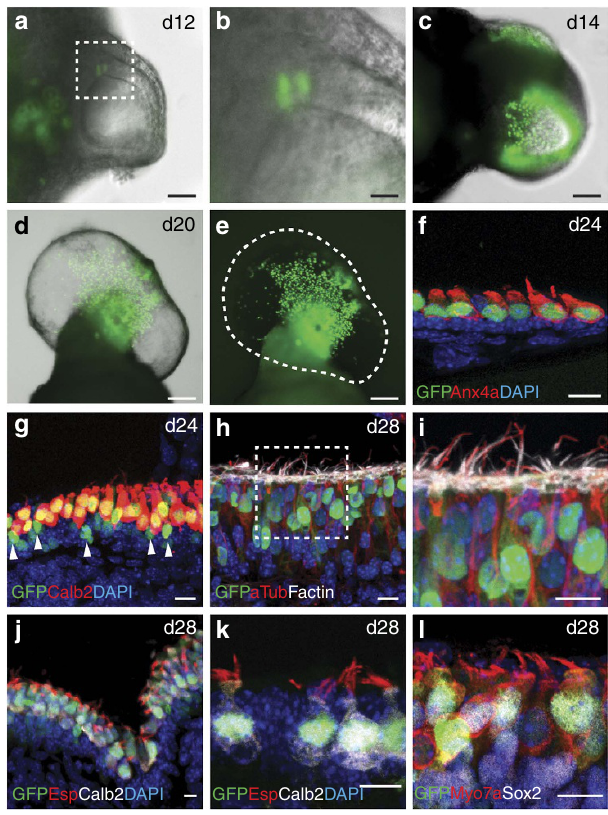
Figure 2 | Inner ear organoids generated from Atoh1/nGFP ES cells include nGFP þ cells that expressed multiple hair cell markers. ( a , b ) The appearance of nGFP þ cells in the epithelium of organoid vesicles on day 12 of differentiation. ( c ) At later stages of differentiation ( 4 day 14), numerous nGFP þ cells populated the epithelium, typically in a regional cluster as seen in d and e . ( f , g ) Most nGFP þ cells were also Anx4a þ and Calretinin (Calb2) þ . Arrowheads in g denote nGFP þ cells devoid of Calb2. ( h , i ) nGFP þ hair cells had acetylated-tublin þ kinocilia and F-actin þ hair bundles. ( j , k ) Most Calb2 þ hair cells also had Espin þ hair bundles. ( l ) nGFP þ cells were also Myo7a þ and Sox2 þ . Scale bars, 100 m m ( a , c , d and e ), 25 m m ( b ) and 10 m m ( f – l